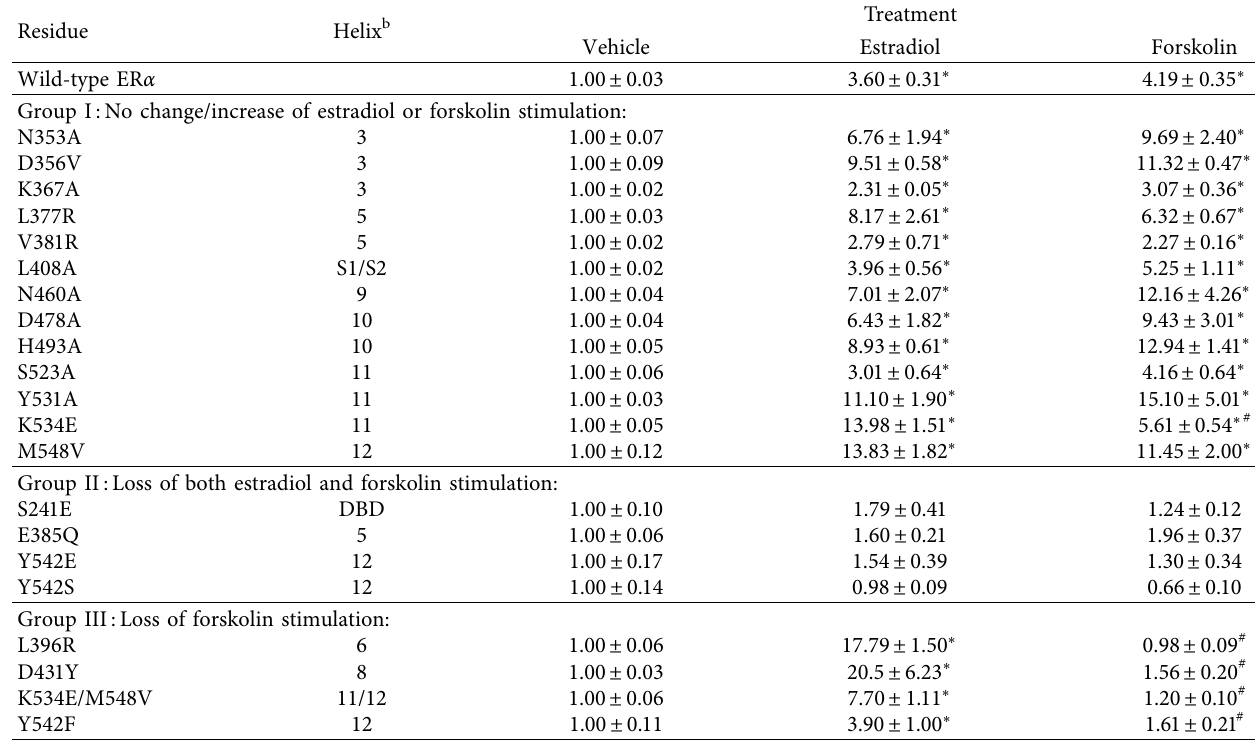
Table 1: Transcriptional activity of ER α and its mutants in response to estradiol or forskolin a .